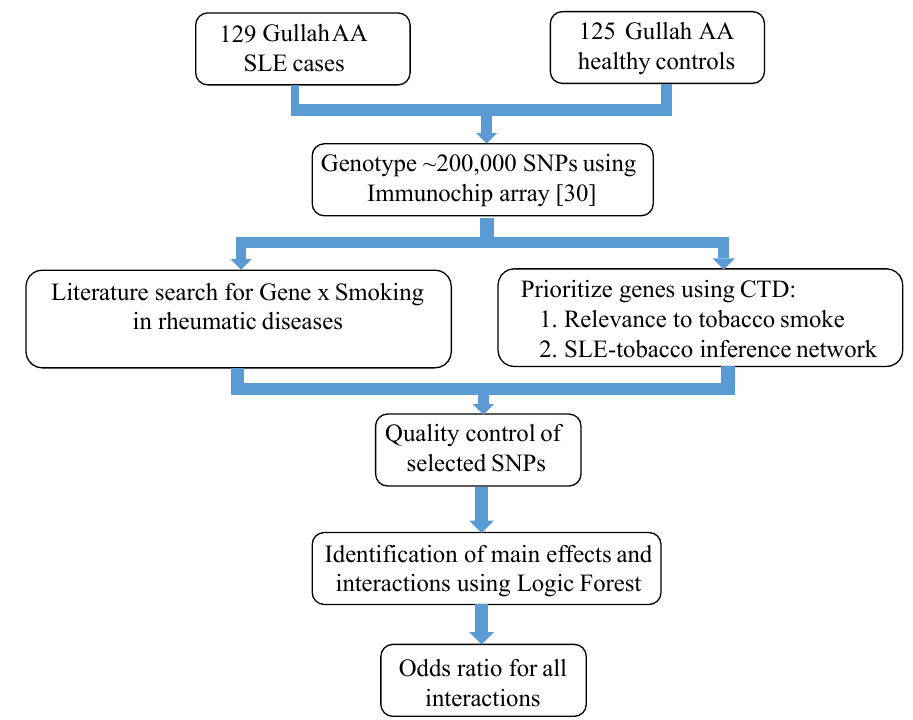
Figure 1. Flowchart of the proposed analytic approach. AA: African American; SLE: Systemic lupus erythematosus; CTD: Comparative Toxicogenomics Database, and SNP: Single nucleotide